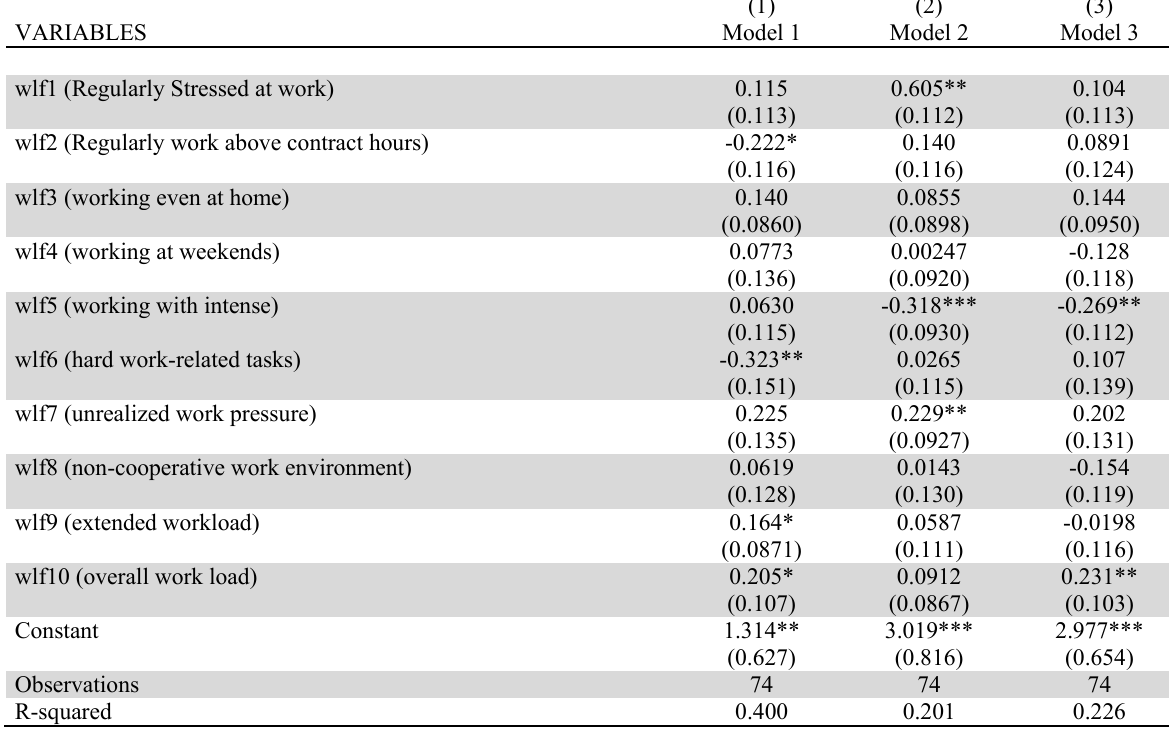
Regression Findings for Workload factors and employee’s